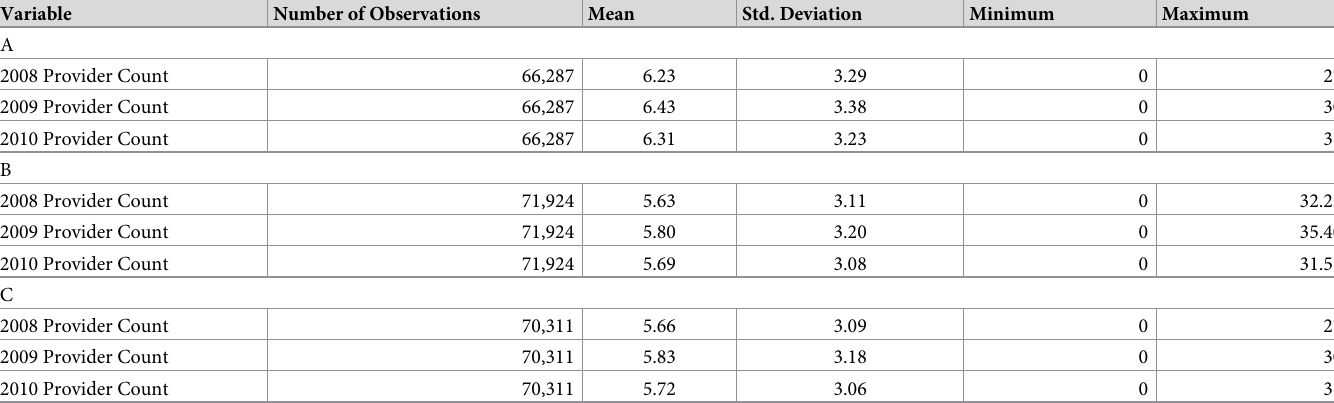
Table 7. A comparison of provider counts (2008–2010). A . Summary statistics for original form 477 tract data. B . Summary statistics for the entire BITS. C . Summary statistics for observations within the +/-5 margin of uncertainty.